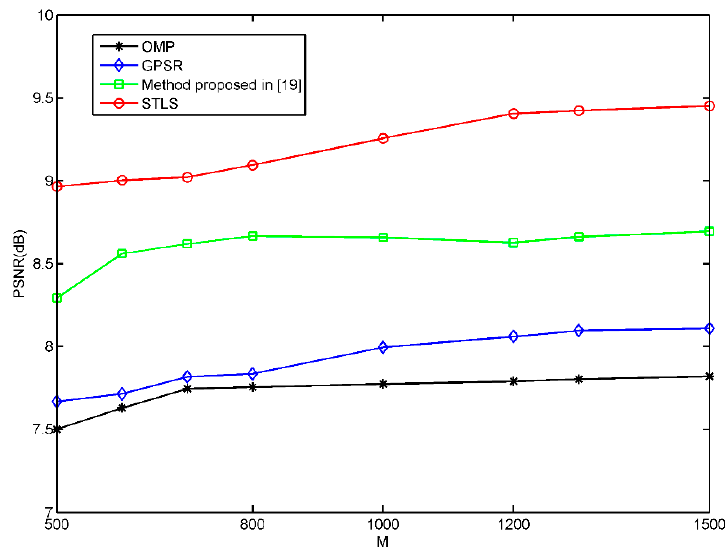
Figure 8. PSNR of the reconstructed quantum ghost imaging with OMP, GPSR, Method proposed in [19] and STLS with different sampling numbers.